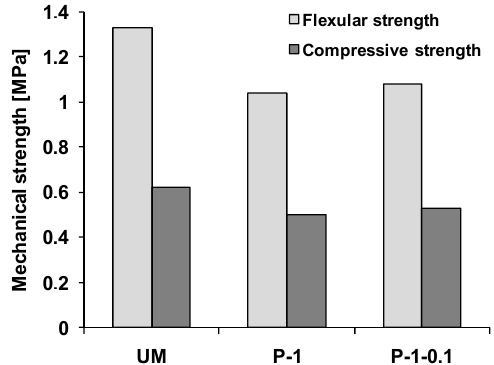
Figure 5. Changes of mechanical properties of gypsum samples after loading of TiO 2 /N and glass fiber. Materials 2019 , 12 FOR PEER REVIEW